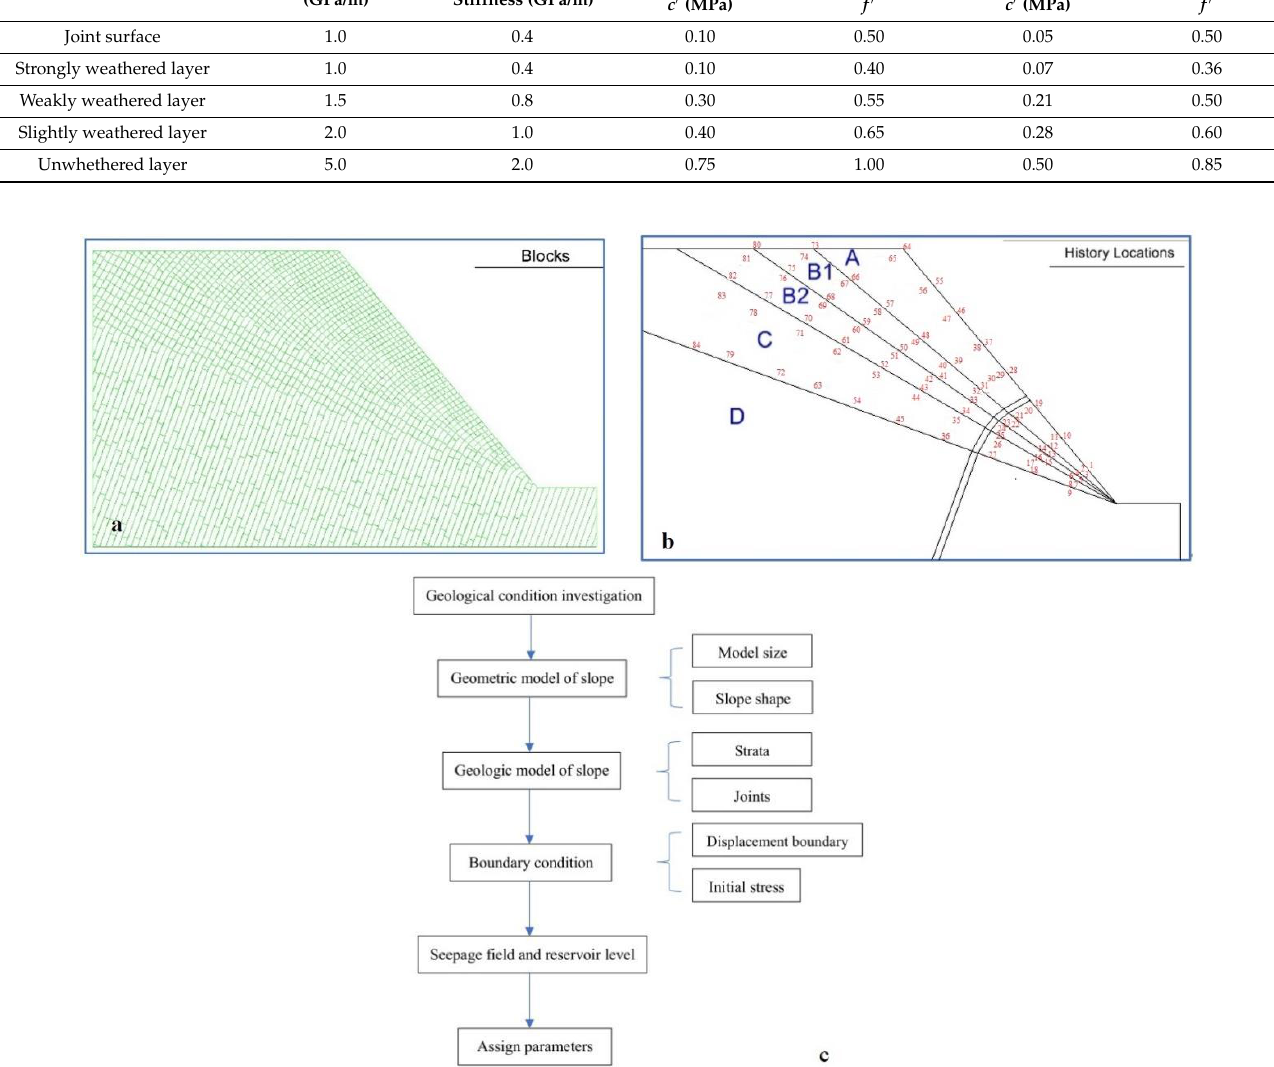
Figure 2. The calculation model and monitoring point. ( a ) The geometric model. ( b ) The monitoring point. ( c ) The flow chart of the modeling. Table 1. The physical and mechanical parameters of rock mass.